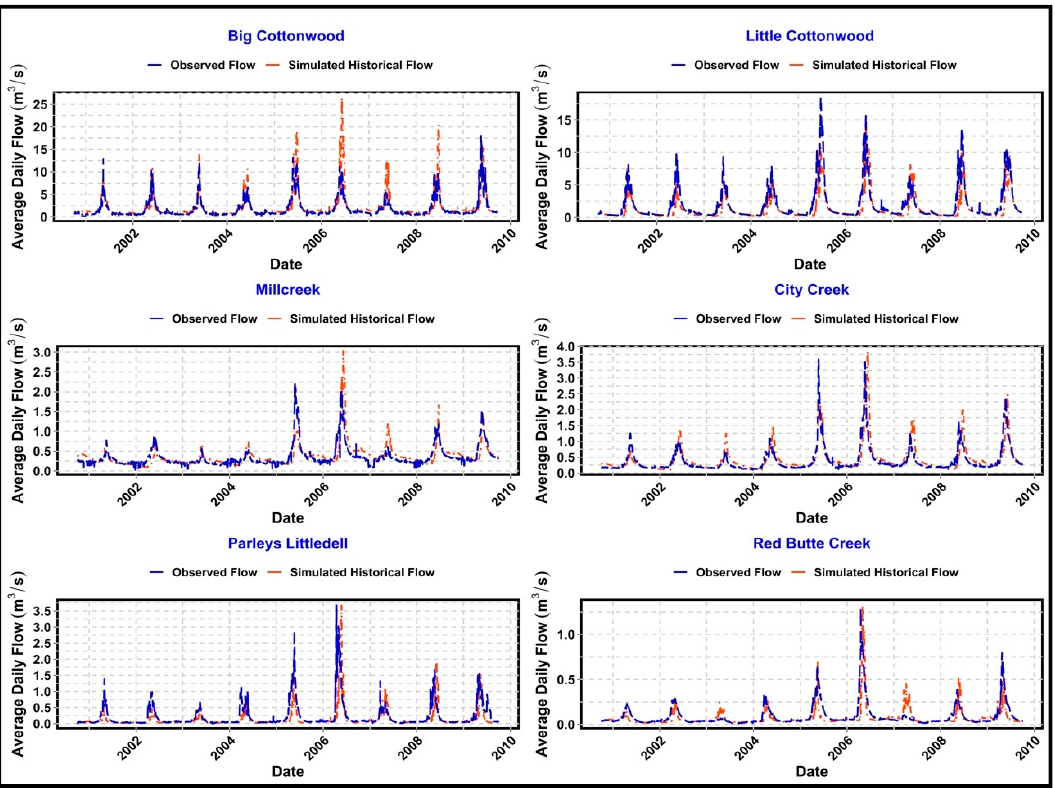
Figure 7. Observed and simulated streamflow using dynamically downscaled climate projection for the historical baseline period. Table 6. Results of di ff erent statistical tests to evaluate the historical baseline scenario results based on average daily